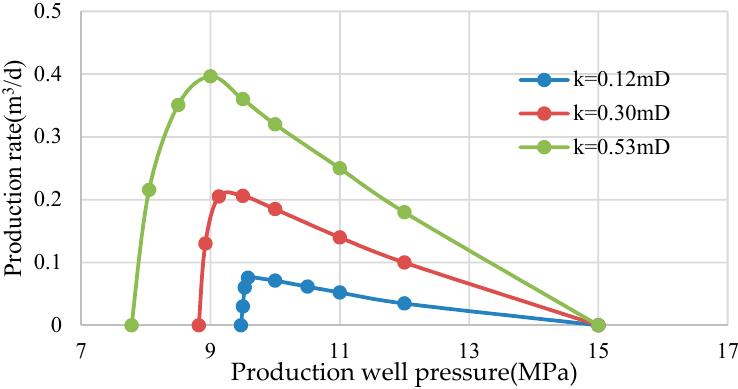
Figure 14. The relationship between the production rate and the production well pressure before fracturing.